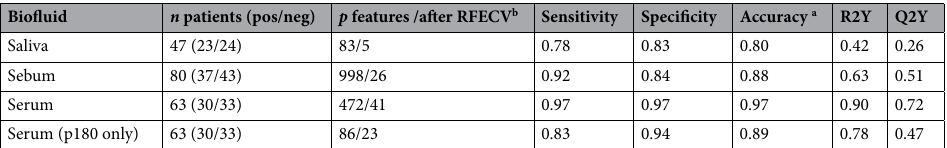
Table 2. Comparison of PLS-DA model performance across three different biofluids using leave-one-out- cross-validation to assess performance. a All PLS-DA models used 5 components except saliva which found maximum accuracy with 3 components. b Number of features in model is the smaller number after recursive feature elimination with